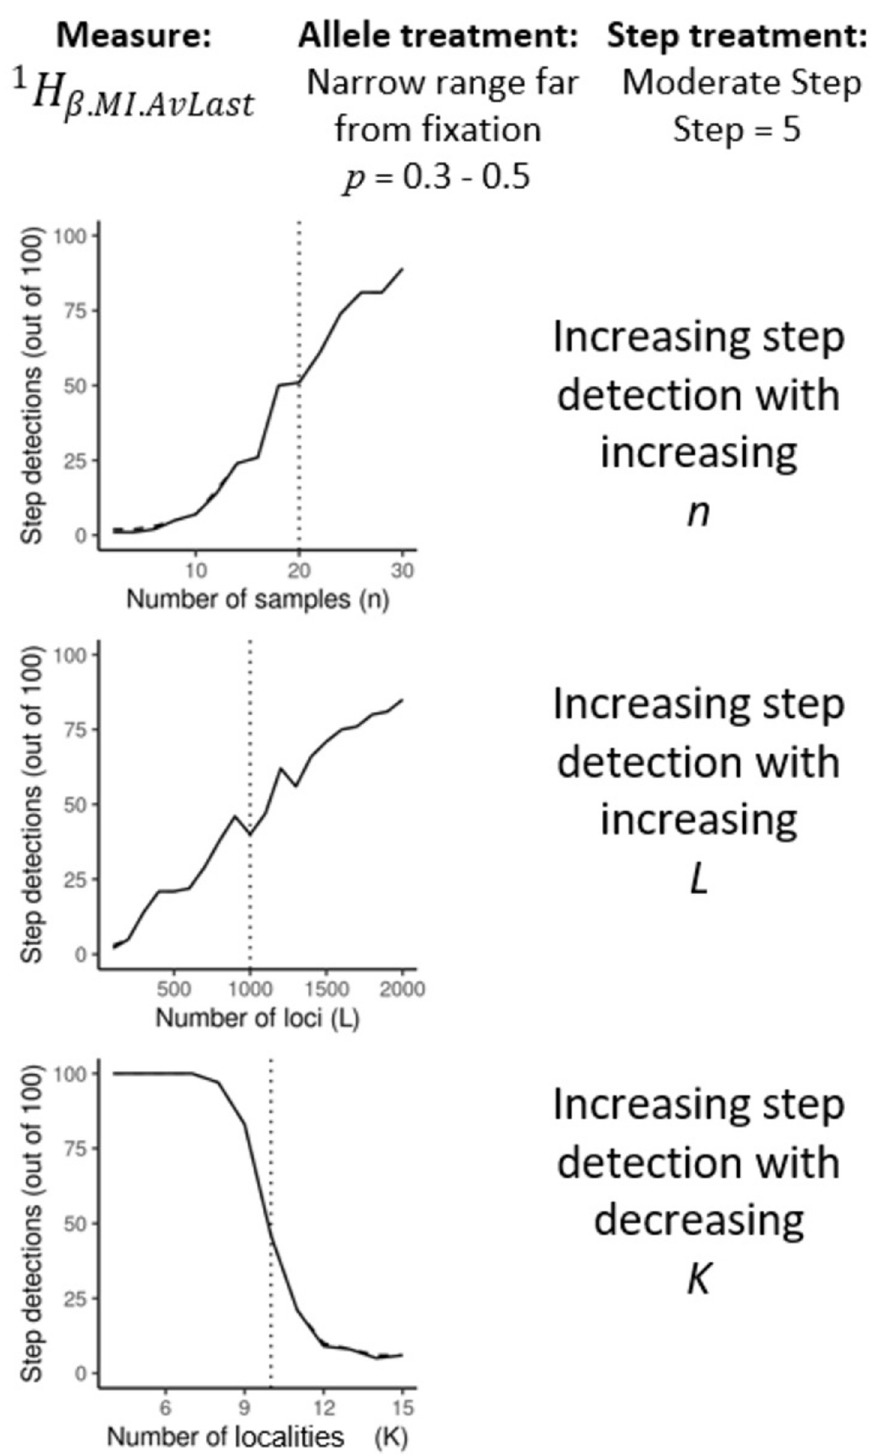
Fig 2. Example of how true positives generally respond to the varied number of genomes ( n ), number of loci ( L ) and number of localities ( K ). The dashed line indicates the values used in the standard treatments. These results were taken from an AvLast variant of a q = 1 measure under the moderate step treatment ( step = 5) and the narrow range far from fixation allele proportion treatment ( p = 0.3–0.5). For full results for the six chosen measures and treatments, see Supplement S3 File.